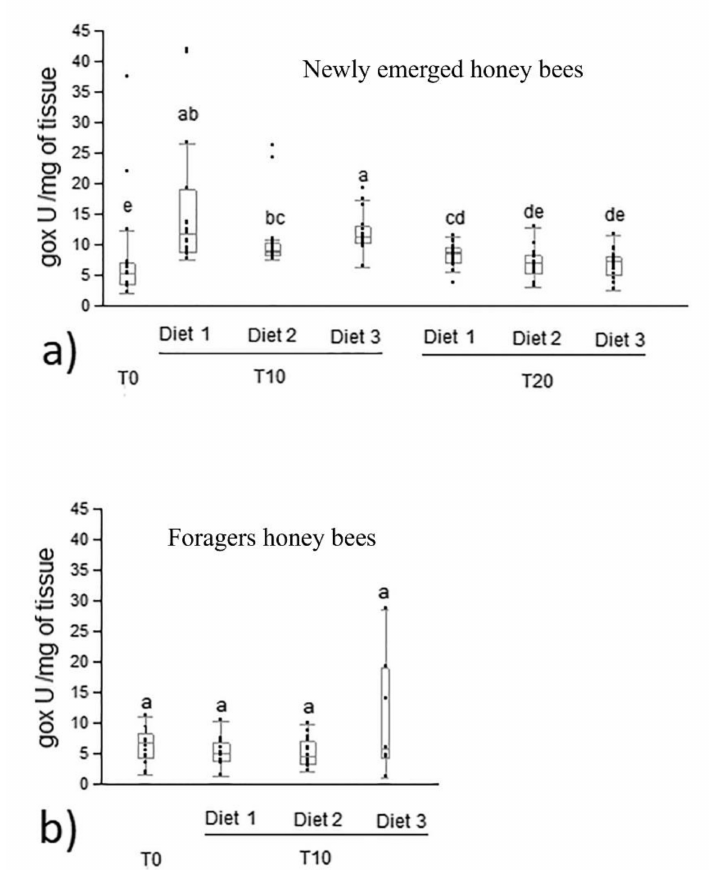
Figure 3. Glucose oxidase activity in newly emerged ( a ) and forager ( b ) honey bees fed with control and experimental diets (diet 1, diet 2, diet 3 with 0.3%, 1.7% and 7.7% of protein content, respectively). Different letters on each bar indicate statistical significance ( p < 0.0001) by Kruskal–Wallis test. Data were expressed as U/mg of tissue (median, min and max values). T0, T10, T20 were the day of honey bee sampling, n = 15 per